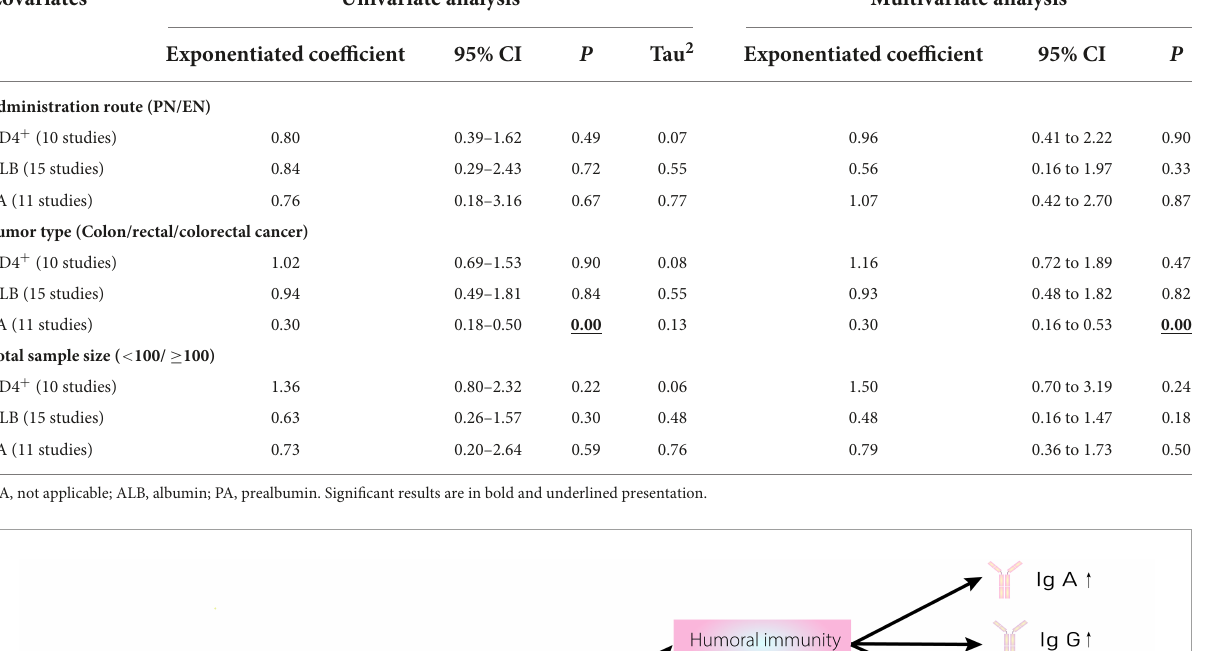
can induce the expression of prostaglandins, leukotrienes, and thromboxane A2, resulting in a severe stress response that leads to immunosuppression, platelet aggregation, and excessive inflammatory response (61). Figure 10 shows the interaction